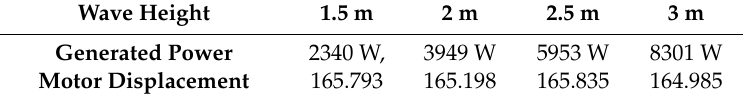
Table 1. The maximum generated power and its motor displacement at different wave periods.